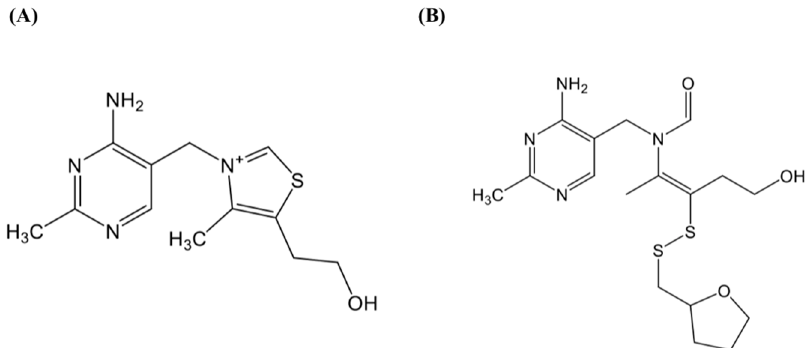
Figure 1. The structure of thiamine ( A ) and thiamine tetrahydrofurfuryl disulfide ( B ).